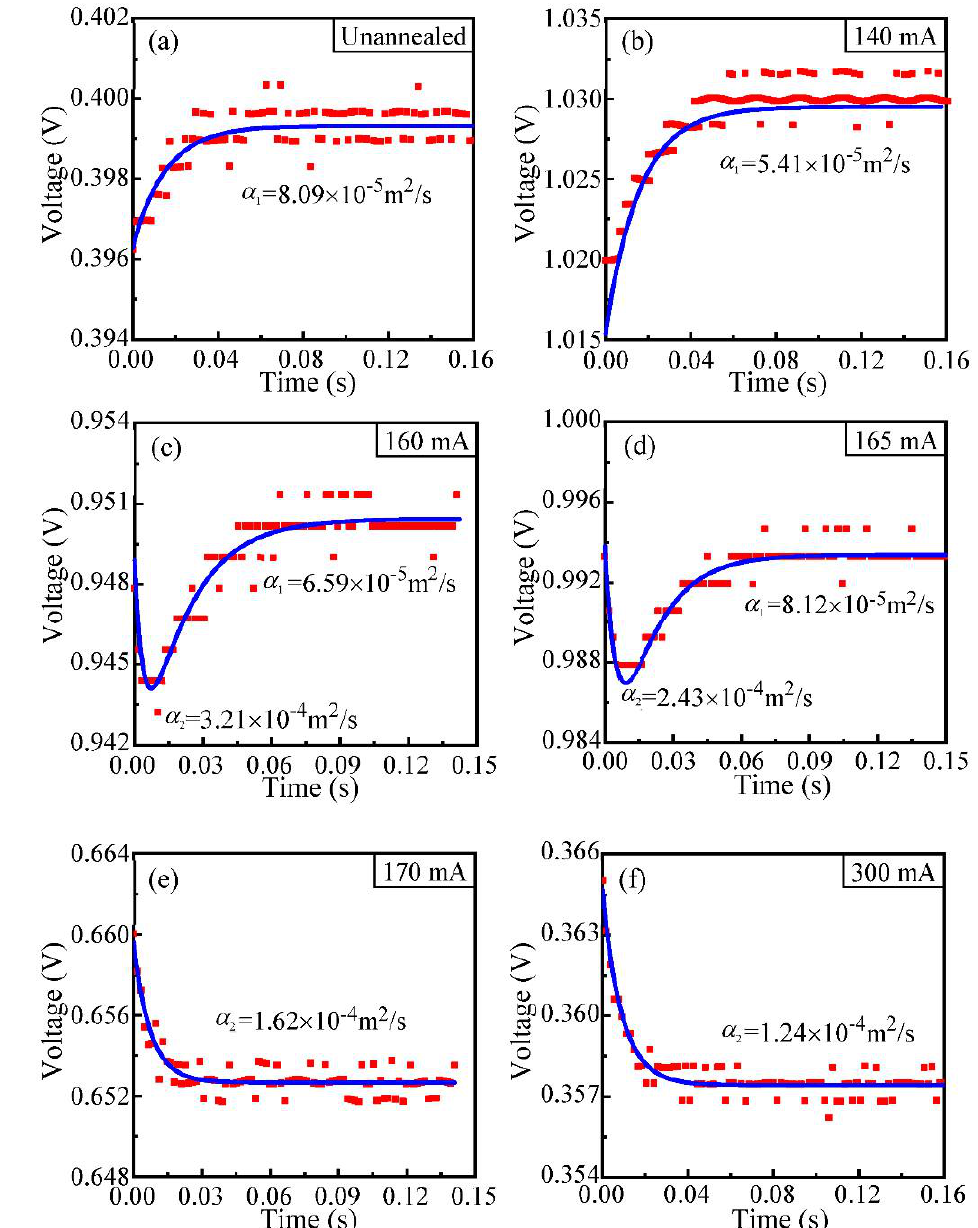
Figure 3. ( a – f ) Comparisons between the theoretical fitting and experimental data of CNTB2 for the voltage under different annealing currents. The red squares are experimental data, and the blue lines are the theoretical fitting. ( a ) Corresponding to the unannealed state and the variation of voltage is monotone increasing, which trend is similar to ( b ) under 140 mA. ( c , d ) are under 160 mA and 165 mA, respectively. The variations perform as decreasing firstly and then rising to the steady-state. ( e , f ) 170 mA and 300 mA, respectively, and the variations are monotone decreasing.